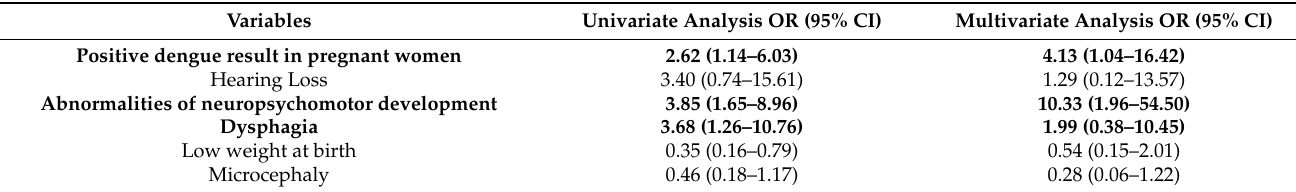
Table 6. Multivariate analysis of the factors associated with ZIKV infection in the newborns of the cohort, Jundia í medical School,